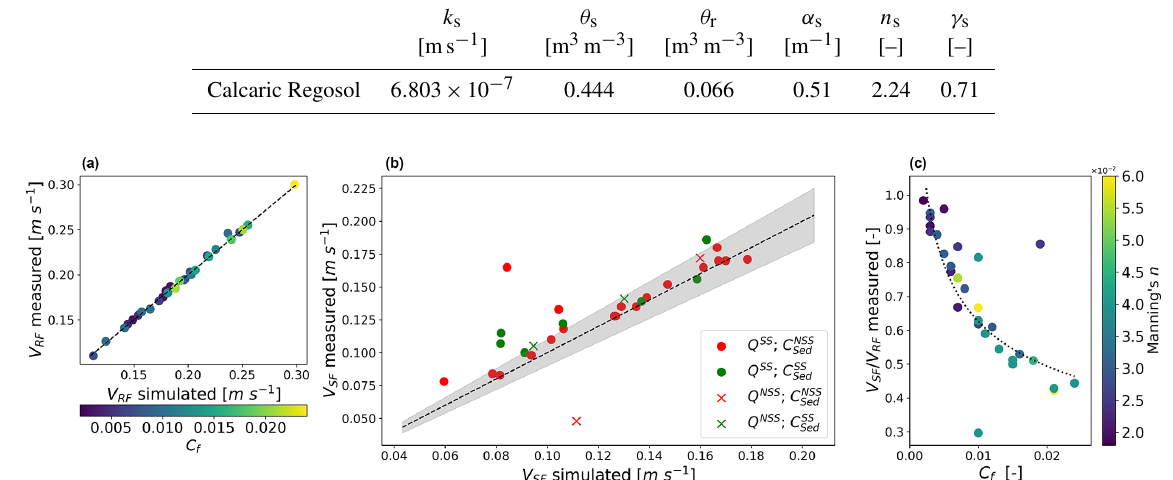
Figure 9. Results of calibration of flow accumulation to observed rill flow velocities: (a) v RF , sim vs. v RF , obs , (b) v SF , sim vs. v SF , obs and (c) C f vs. v rat = v SF , sim /v RF , sim